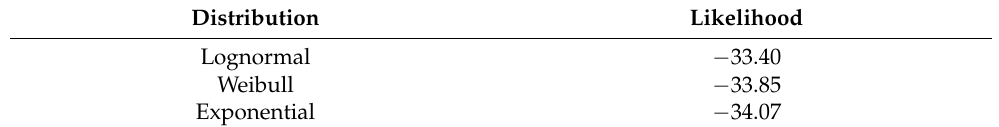
Table 4. Fit results of life distribution.